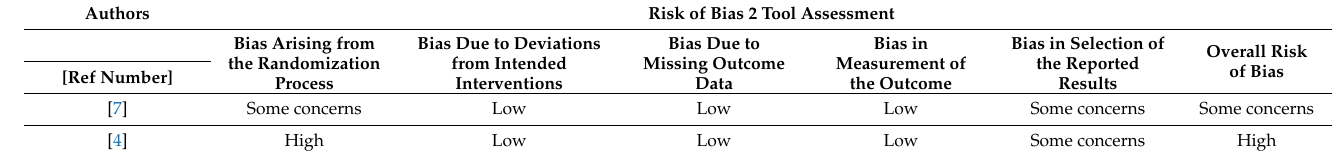
Table A1. Quality scores for the eligibility studies for mean operative time.